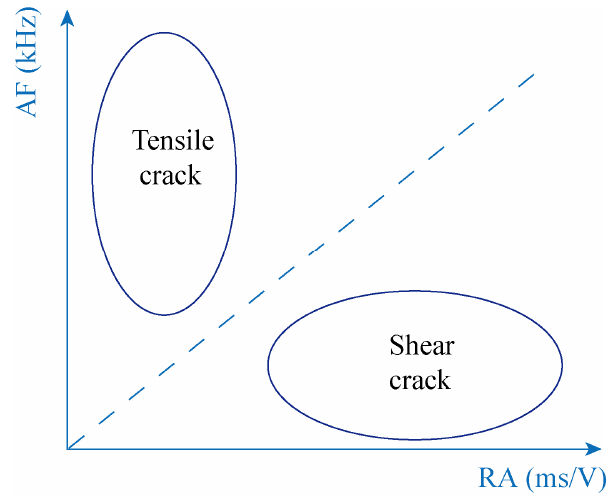
Figure 10. Fracture mode classification criterion.